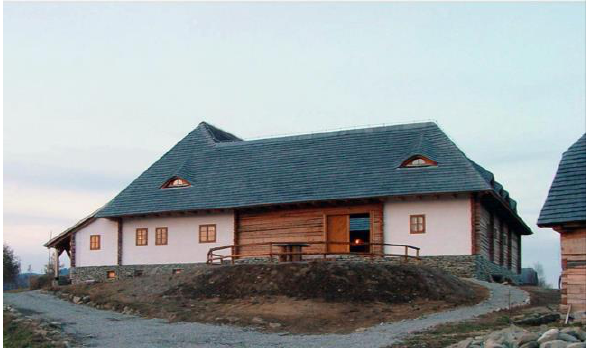
Figure 2. Inn on the Balaban Hill, 2006. Bran, Romania. Attila Zakariás and Kázmér Kovács, architects.